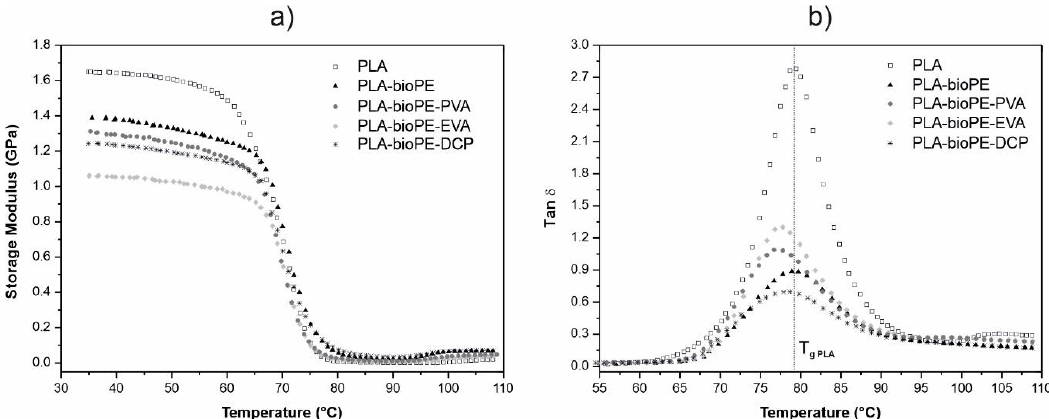
Figure 3. Comparison of the evolution of the ( a ) storage modulus (G’) and ( b ) dynamic damping factor (tan δ) for neat PLA, PLA-bioPE, and PLA-bioPE with different compatibilizers.